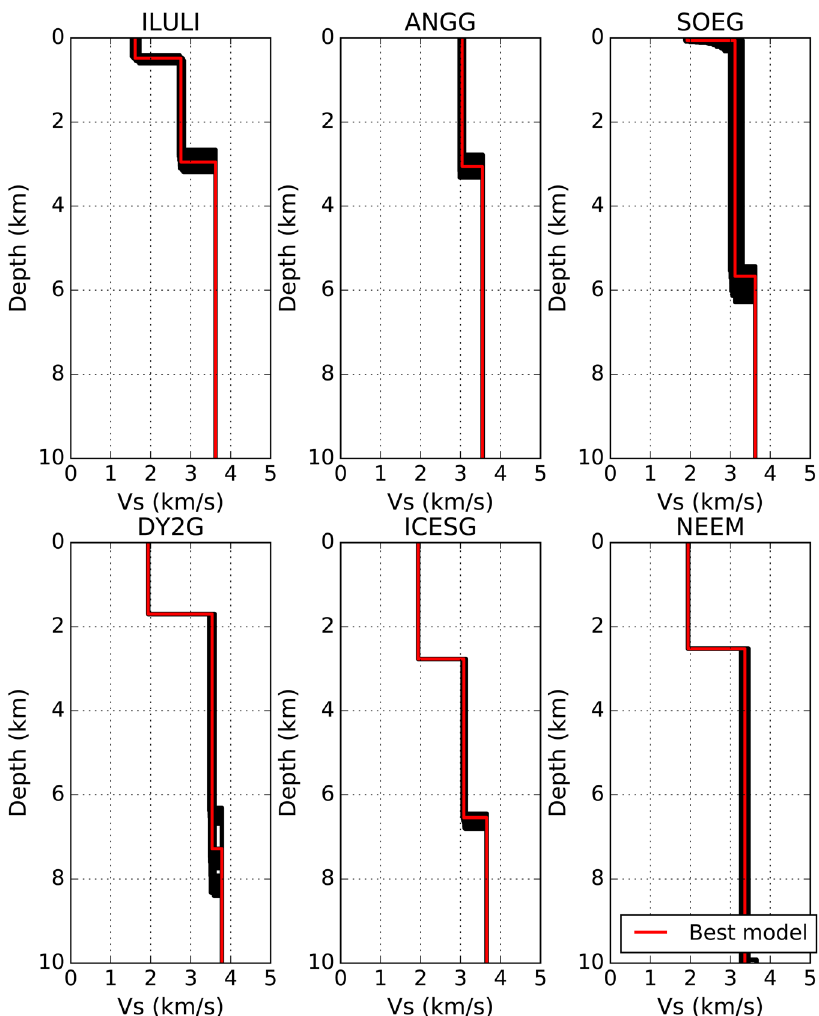
Fig. 6 1-D V s pro fi les computed for illustrative off-ice (top row) and on-ice (bottom row) stations. Ensemble models de fi ning the uncertainty ranges are selected as those models that are within 20% of the minimum mis fi t. The red line is the minimum mis fi t model and the black lines are ensemble